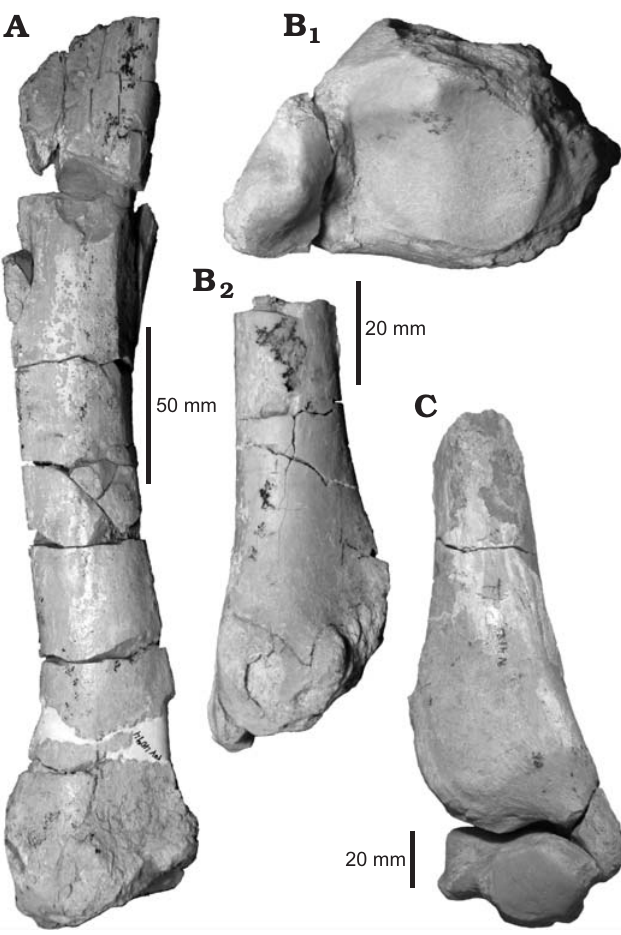
Fig. 5. Tibiae of leontiniid notoungulate Gualta cuyana Cerdeño and Vera, 2015 from Quebrada Fiera, Mendoza, Argentina; Deseadan SALMA (late Oligocene). A . MCNAM-PV 4094, posterior view. B . MCNAM-PV 4785, distal (B 1 ) and posterior (B 2 ) views. C . Tibia, MCNAM-PV 4785, in ante- rior view and astragalus, MCNAM-PV 4891, in distal